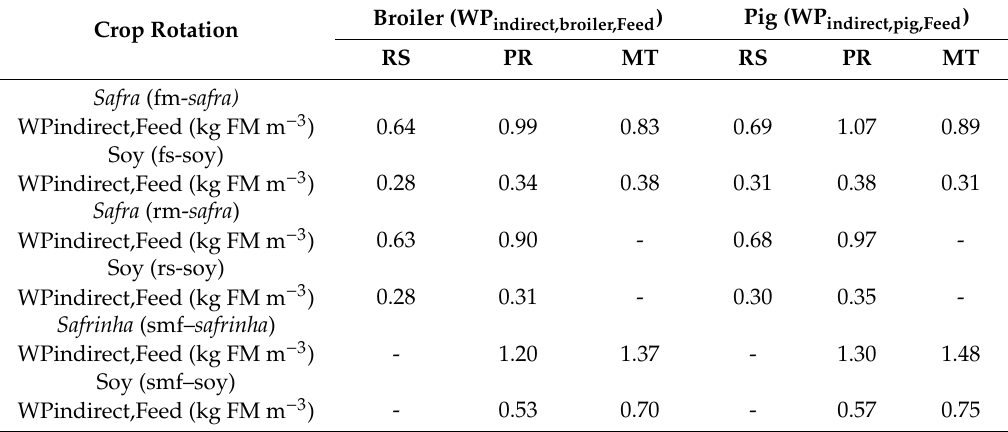
Table 3. WP indirect,Feed of rainfed maize and soy produced in Brazilian sites analyzed (2008 / 18) in the 1st scenario (CY). RS: Vacaria (city) located in Rio Grande do Sul State; PR: Cascavel (city) located in Paran á State; MT: Primavera do Leste (city) located in Mato Grosso